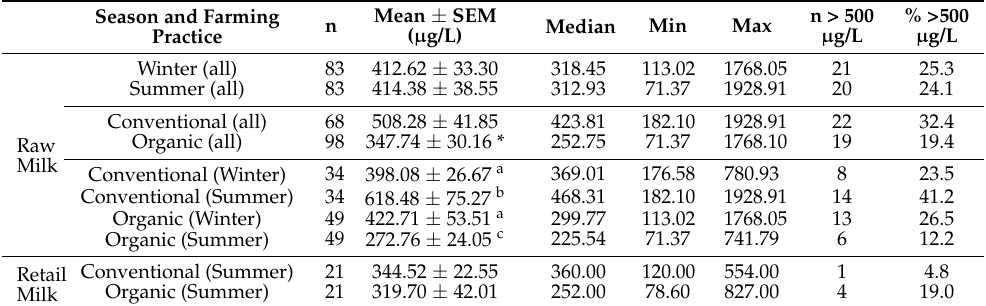
Figure 1. Iodine concentrations in raw milk originating from conventional and organic farms across different seasons using an ion-selective electrode method. ( A ) Average iodine concentrations in the winter vs. summer; ( B ) Average iodine concentrations in conventional vs. organic; ( C ) Average iodine concentrations in each of the four groups (across types and season). Data are shown as mean ± SEM. Asterisks (*) represents statistical significance on the main effect of farming practice ( p < 0.0001) with a linear mixed-effect model with repeated measures analysis. Interactive effect of farming practice x season was also observed ( p < 0.0001). Different letters (a–c) stand for statistical differences ( p < 0.05) between each group shown by post hoc Tukey’s test. Table 1. Iodine concentrations ( μ g/L) detected in both raw milk and retail milk samples from con- ventional and organic farming across different seasons (winter and summer).